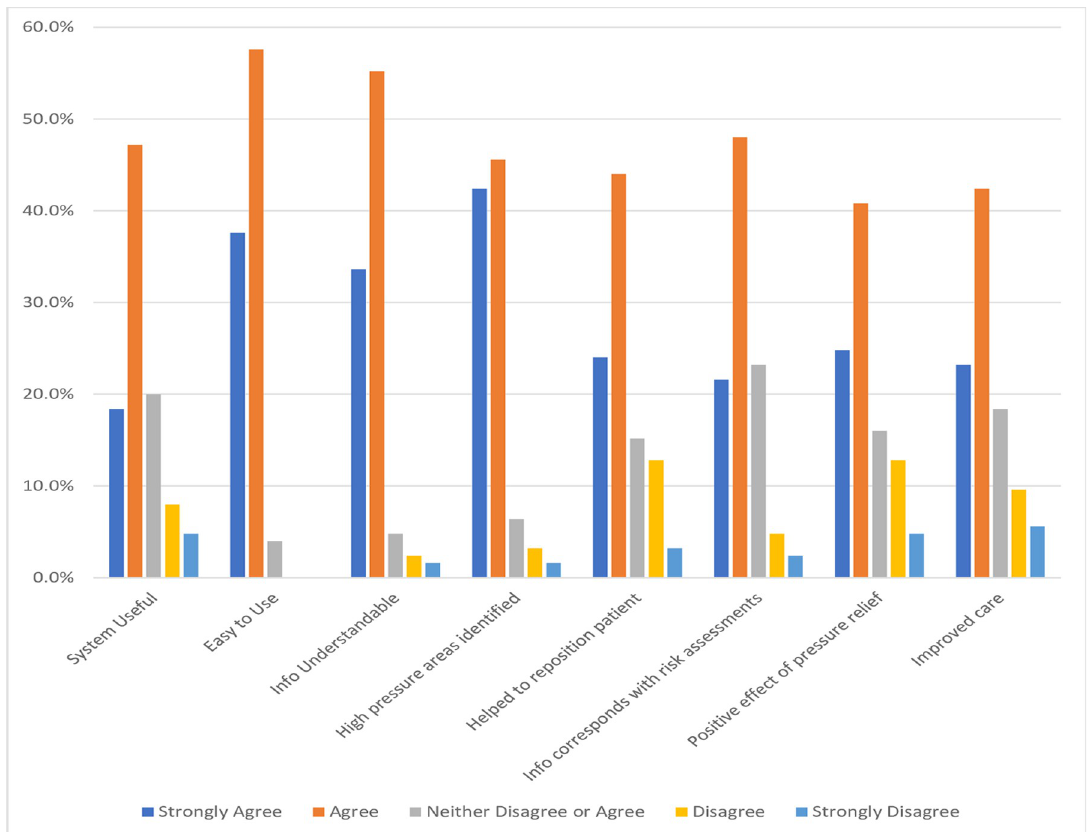
Fig 1. Health care providers responses to multiple choice survey